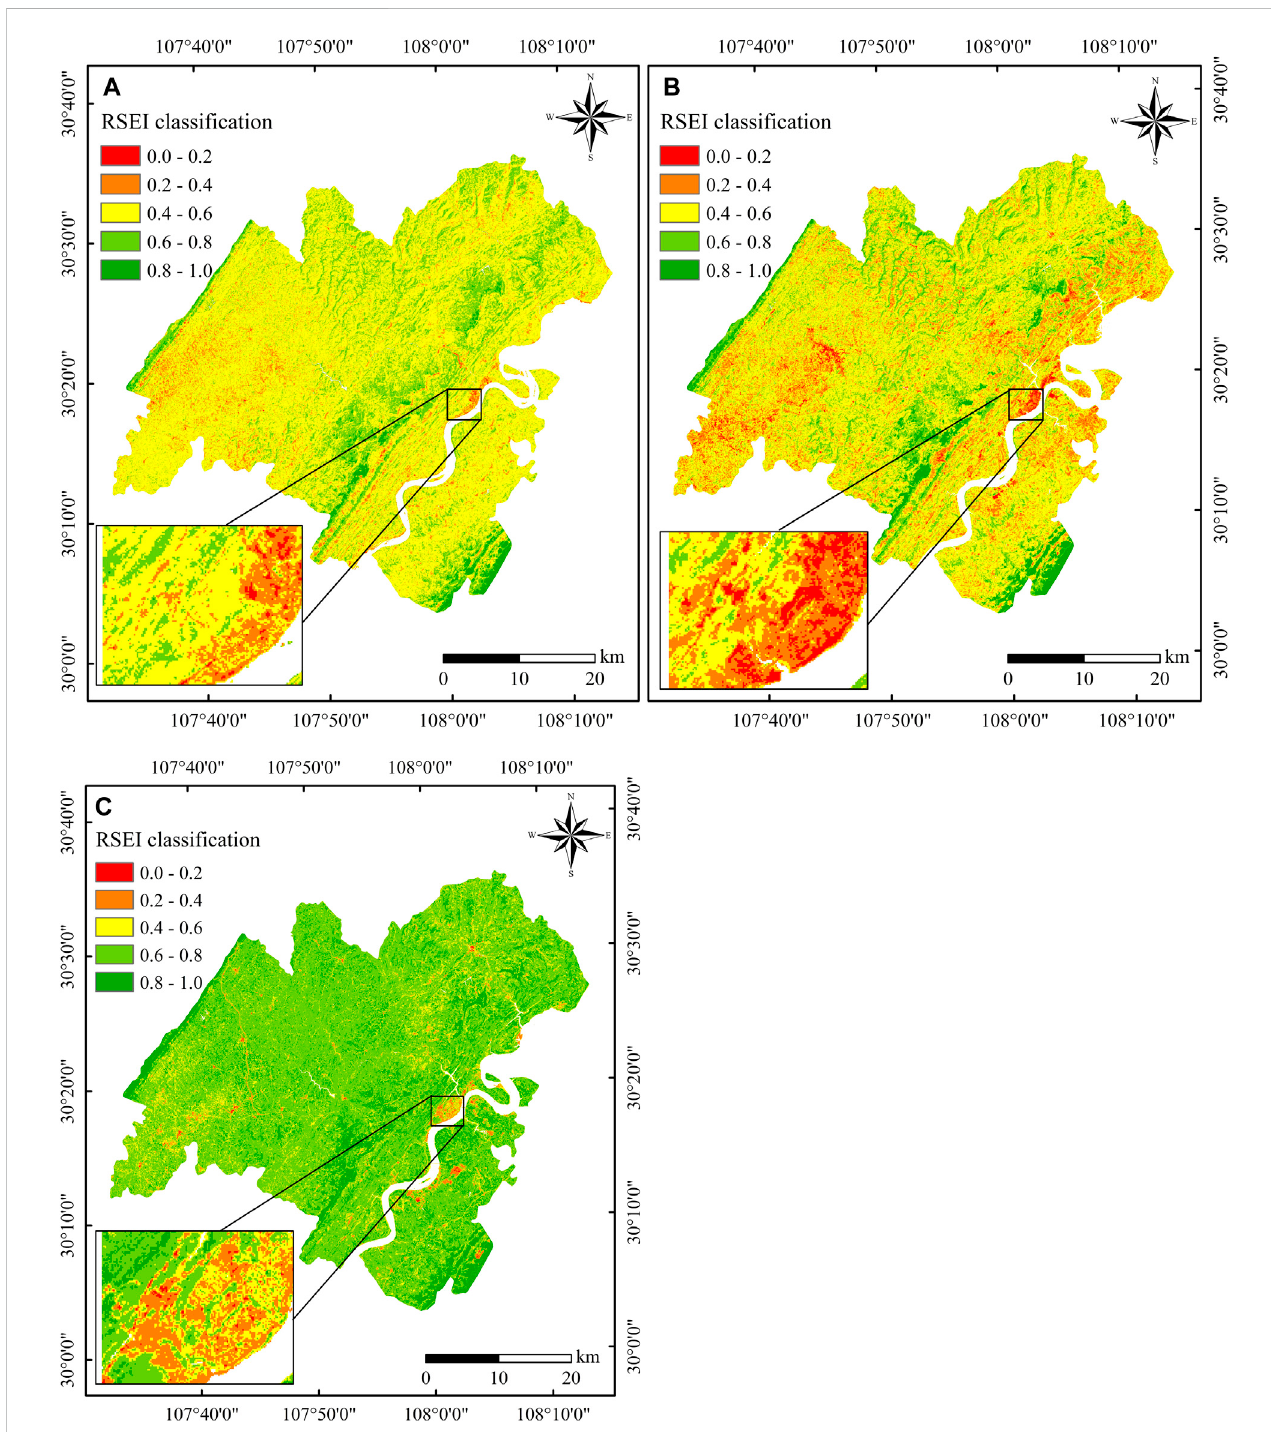
FIGURE 2 2002 (A) , 2009 (B) and 2016 (C) RSEI of Zhongxian County (water body mask treatment, the picture at the lower left corner shows the location of Zhongxian County administrative